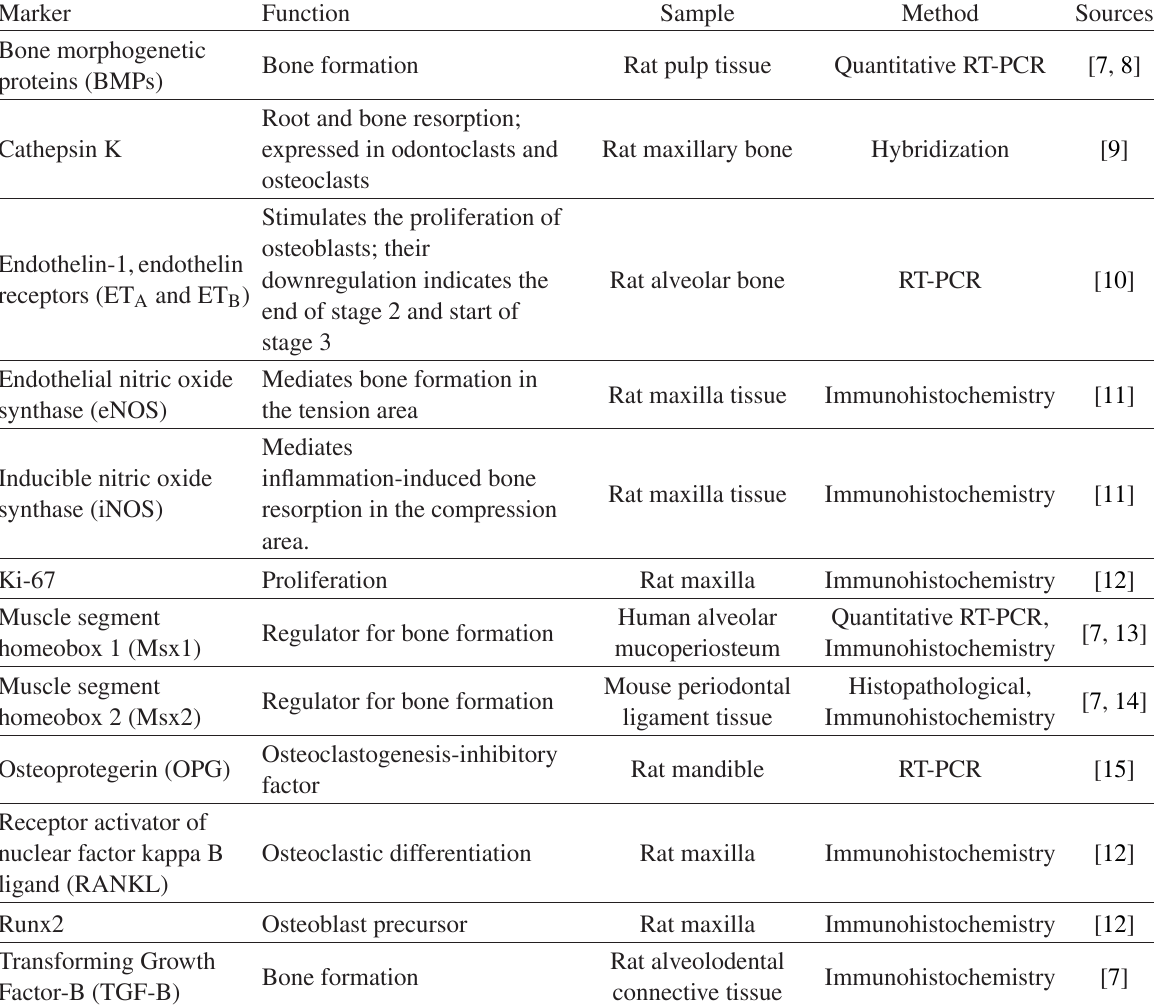
TABLE 1: Markers involved in orthodontic tooth movement collected from dental tissues (alveolar bone, periodontium and